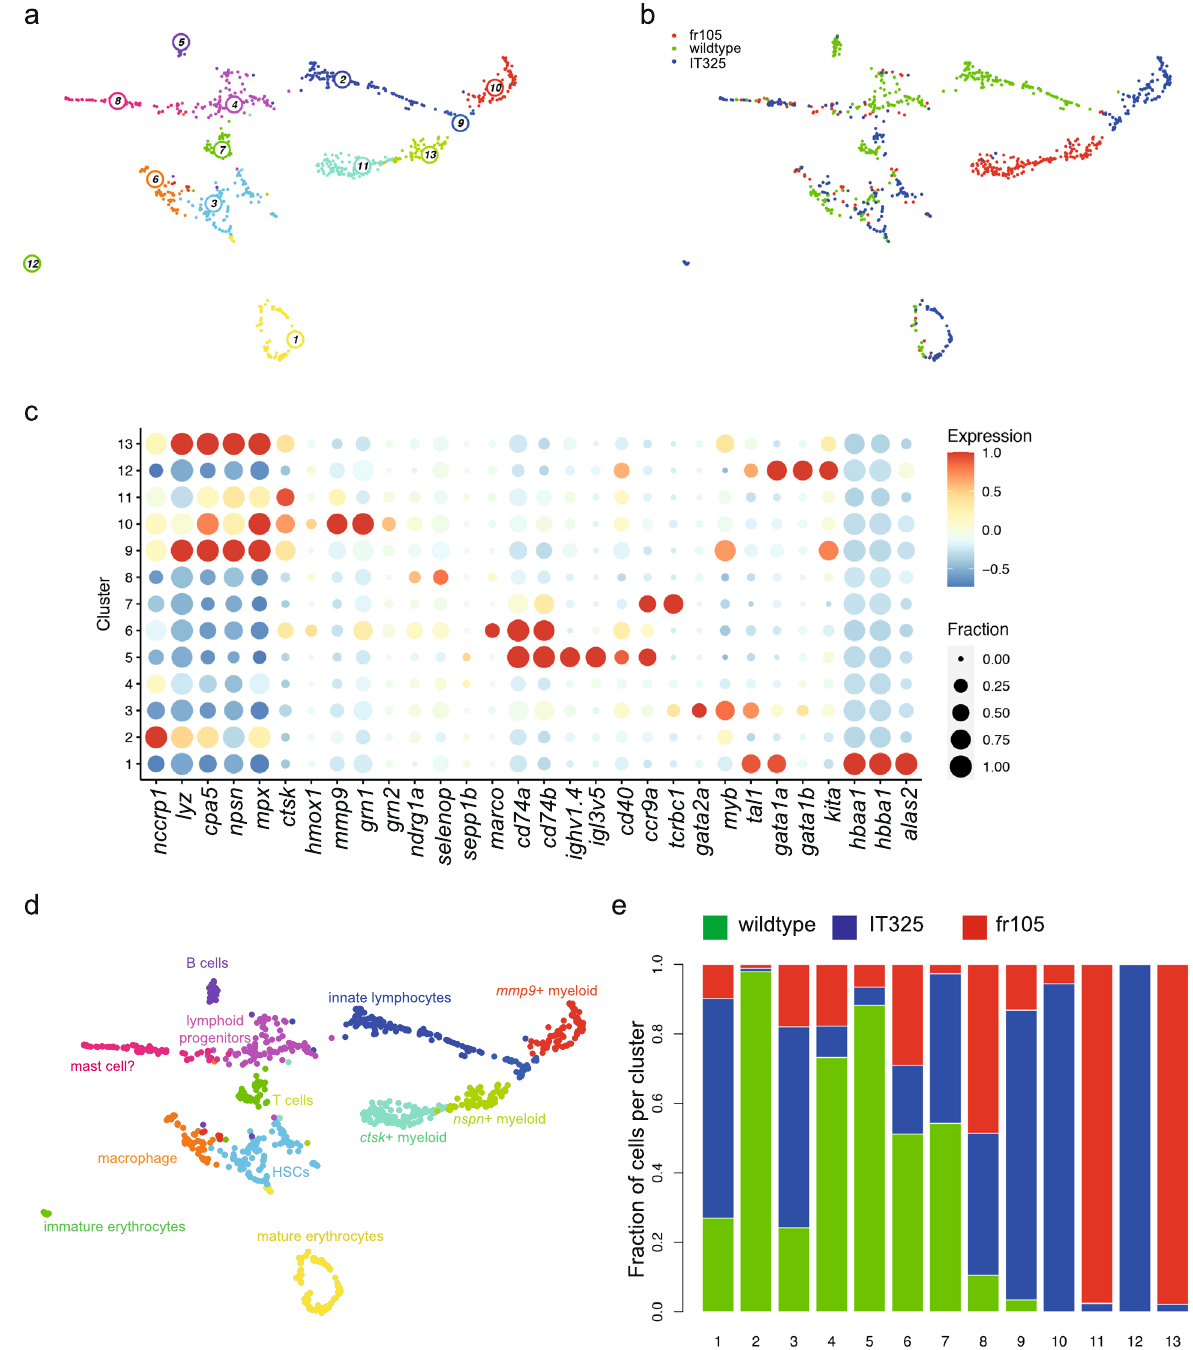
Figure 2. Transcriptional landscape of whole kidney marrow cells of IT325 and fr105 mutants. ( a ) Uniform manifold approximation and projection (UMAP) representation of transcriptome similarities determined by combined analysis of 341 wild-type, 331 mutant cells of the IT325 line, and 262 mutant cells of the fr105 line; the individual clusters are indicated by colour and numbers. Fish were 3 months of age. ( b ) Distribution of wild-type and mutant cells among transcriptionally defined cell clusters; origins of cells are colour-coded. ( c ) Expression pattern of signature genes (listed at the bottom) in the individual cell clusters shown in ( a , b ). Colour represents the z-score of the mean expression of the gene in the respective cluster and dot size represents the fraction of cells in the cluster expressing the gene. z-scores above 1 and below -1 are replaced by 1 and −1, respectively. ( d ) Cell type identification based on signature gene expression patterns (see Table 2, and text for details). ( e ) Distribution of cells of different genotypes in the identified cell